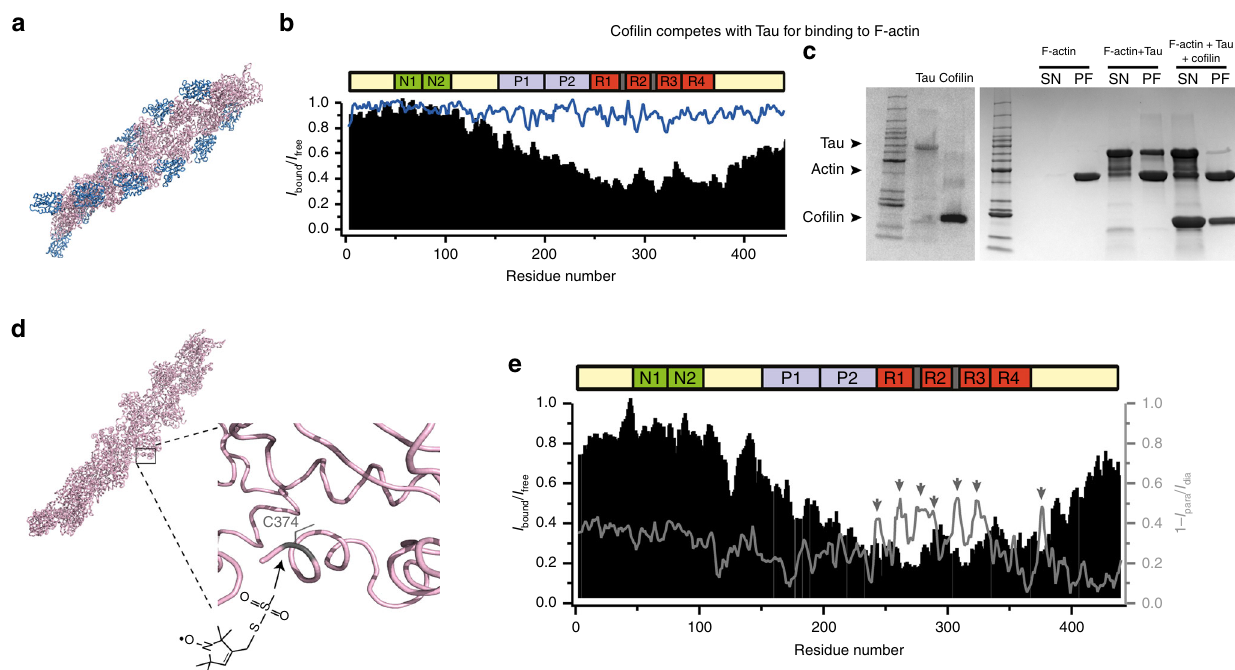
Fig. 2 Tau binds to the hydrophobic pocket of actin. a 3D structure of F-actin (pink) in complex with co fi lin (light blue) (PDB id: 3J0S). b In fl uence of a 10- fold excess of co fi lin on 1 H- 15 N cross-peak intensities of Tau in presence of F-actin (Tau/F-actin molar ratio of 1:1.5). Normalized signal intensities in the absence (black) and presence of co fi lin (blue) are shown. c Centrifugation-based sedimentation of F-actin, F-actin + Tau (1.5:1) and F-actin + Tau+co fi lin (molar ratio 1.5:1:10). Supernatants (SN) and pellets (PF) were loaded in different lanes of a 4 – 20% SDS gradient gel. Arrowheads from top to the bottom represent Tau, actin and co fi lin bands, respectively. d Cys374 of actin is solvent exposed and can be labeled with the spin label MTSSL 37 – 41 . e Sequence- speci fi c paramagnetic broadening induced in Tau by MTSSL-tagged F-actin (gray line). I para and I dia are signal intensities observed for individual cross- peaks in two-dimensional 1 H- 15 N HSQCs of Tau in the presence of a two-fold excess of paramagnetic and diagmagnetic F-actin, respectively. For comparison, the attenuation of Tau signals by diamagnetic F-actin is shown (black